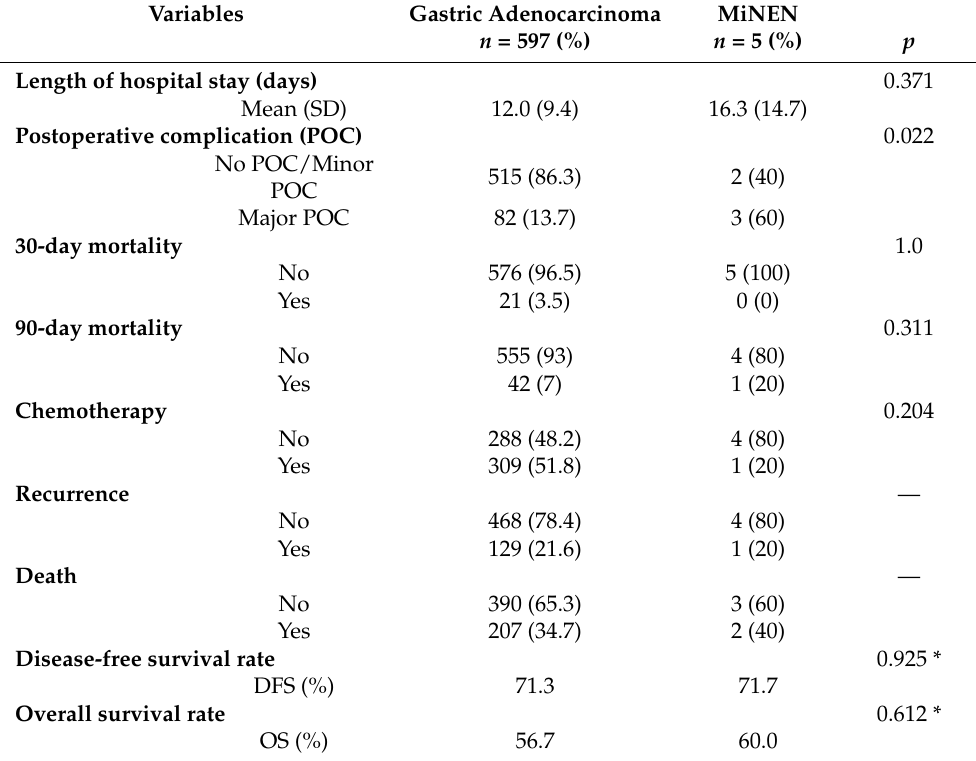
Table 4. Surgical outcomes and follow-up of patients with gastric adenocarcinoma and MiNEN.